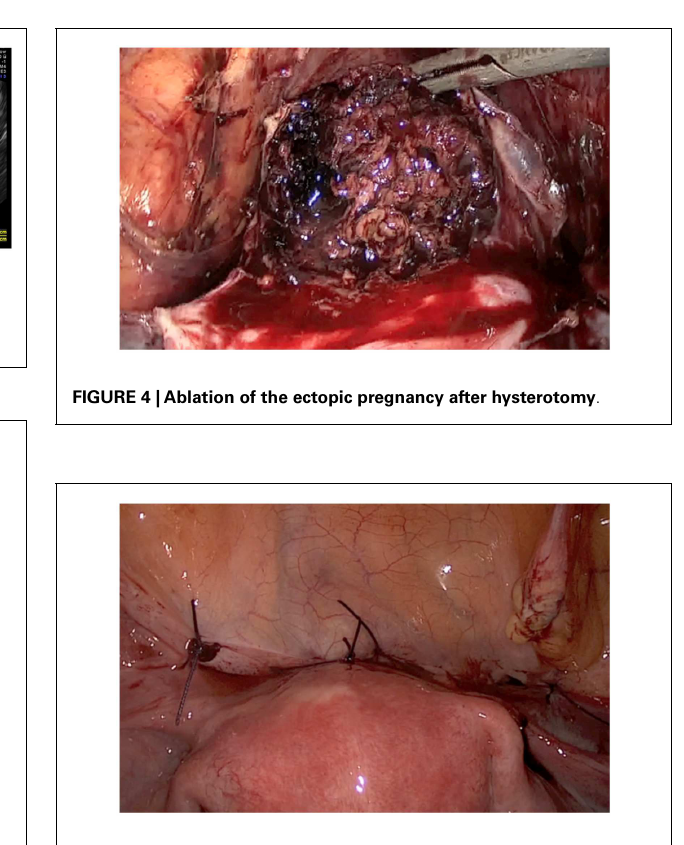
FIGURE 5 | Final aspect after uterine repair in two layers and reperitonealization